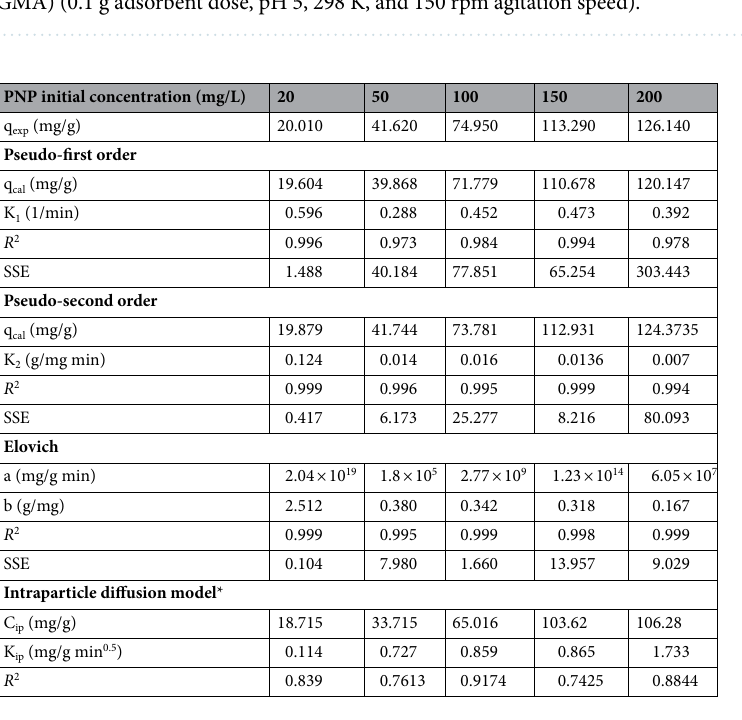
Table 1. The parameters of kinetics models for PNP adsorption on TMA-(PA6- g -GMA). *Represented the calculated parameters derived from the linear model.